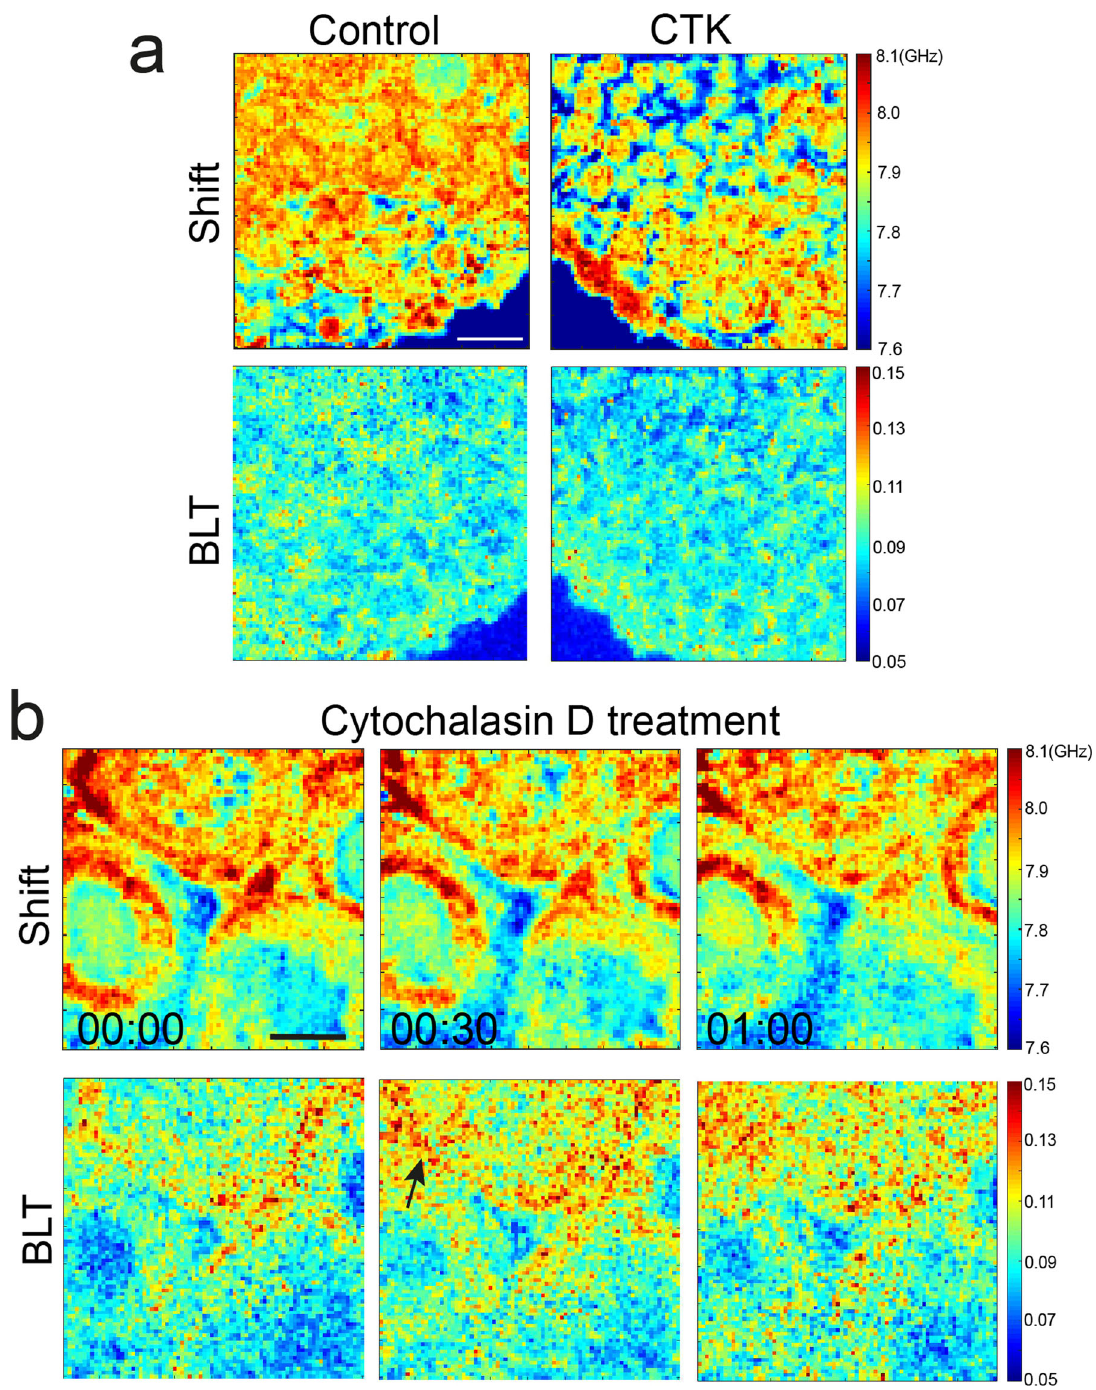
Fig. 5 Disruption of extracellular matrix and actin cytoskeleton impacts interstitial viscoelasticity. a Top row: Brillouin shift of a P14 ovary when treated with CTK, which digests collagen matrix. CTK leads to a clear increase in the interstitial space (blue) between the primordial follicles at the cortex. Bottom row: Corresponding BLT maps. Scale bar = 40 μ m. b Top row: Brillouin shift of a P14 ovary when treated with cytochalasin D, a pharmacological inhibitor that disrupts actin cytoskeleton. Lower row: Corresponding BLT maps showing that a disruption of actin cytoskeleton leads to higher BLT (black arrow) and decreased elasticity of the interstitial tissues. Scale bar = 40 μ m. Time denotes